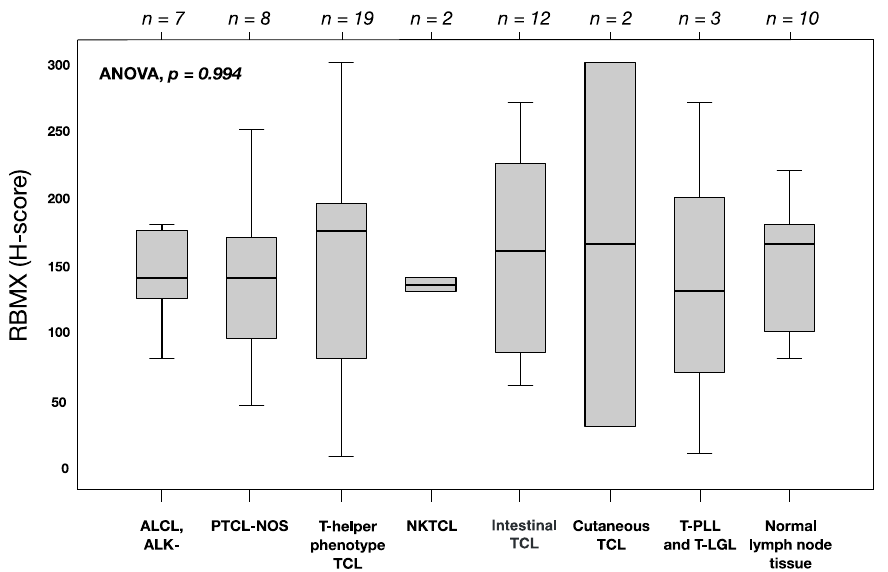
Figure 1. RBMX expression in T-cell lymphoma and non-tumor tissues analyzed by immunohistochemistry. Boxplots represent the median and interquartile range of protein levels. p -values were calculated using ANOVA and post-hoc tests for comparison between histological phenotypes and non-tumor tissues. The number of tissue samples is shown at top. Abbreviations: ALCL, ALK-: anaplastic large-cell lymphoma, ALK-negative; TCL: T-cell lymphoma; PTCL-NOS: peripheral T-cell lymphoma, not otherwise specified; NKTCL: extranodal natural killer/T-cell lym- phoma, nasal type; T-PLL: T-cell prolymphocytic leukemia; T-LGL: T-cell large granular lympho- cytic leukemia.